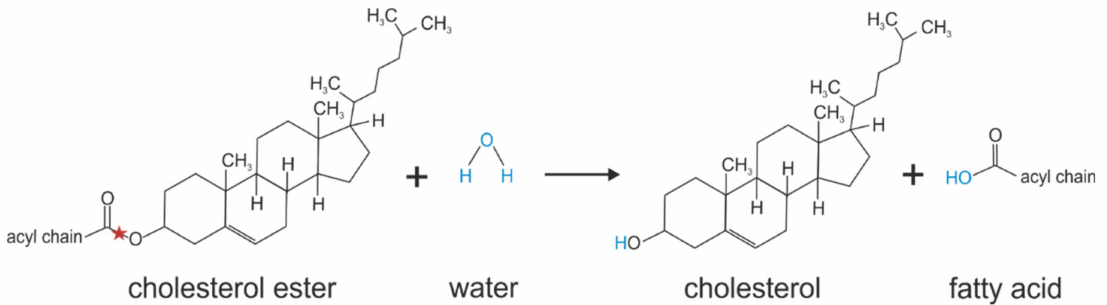
Figure 6. Cholesterol ester hydrolysis catalyzed by KIAA1363. Red stars indicate the bond that is